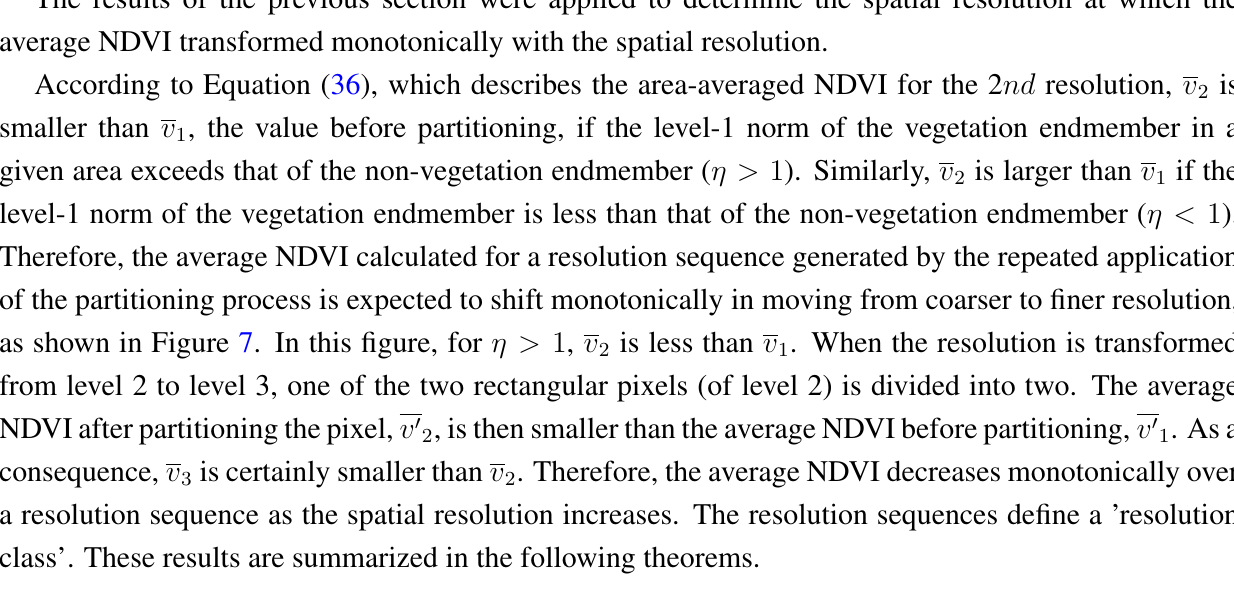
Figure 7. Monotonicity of the area-averaged NDVI in consecutive resolution sequences. A trend increases or decreases depending on the factor (cid:17)